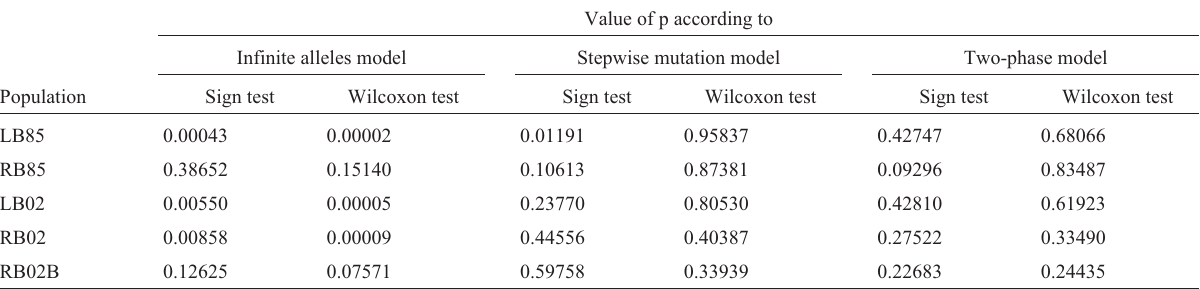
Table 3 - Values of p recorded for the statistical analyses (sign and Wilcoxon tests) of the different mutational models used to evaluate the probability of recent bottleneck events in the study populations, calculated using the Bottleneck program of Piry et al. (1999).